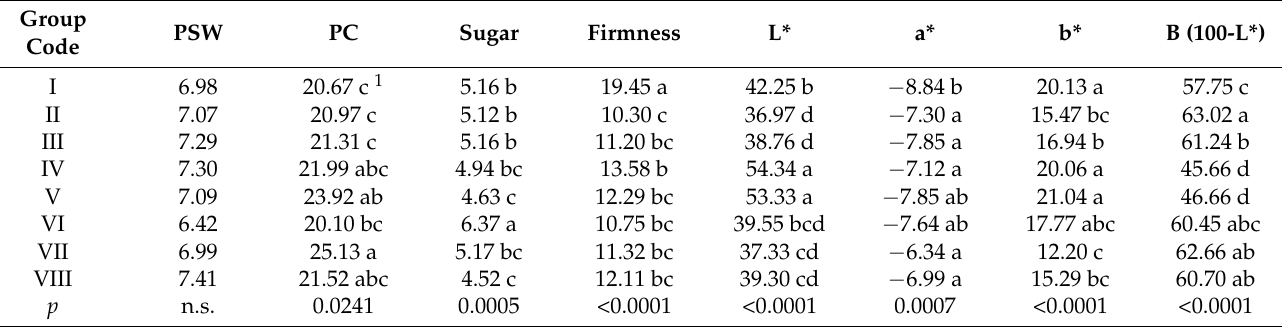
Table 3. Mean values for the traits recorded in the eight pod phenotypic groups established for the set of 54 SBP lines.